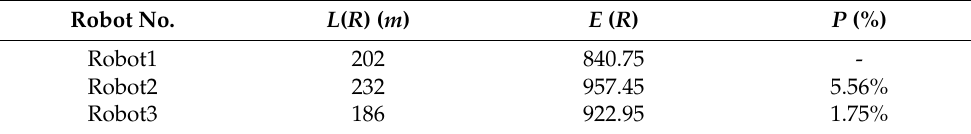
Table 4. Path planning operation parameters of A* algorithm from Experiment 4. Robot